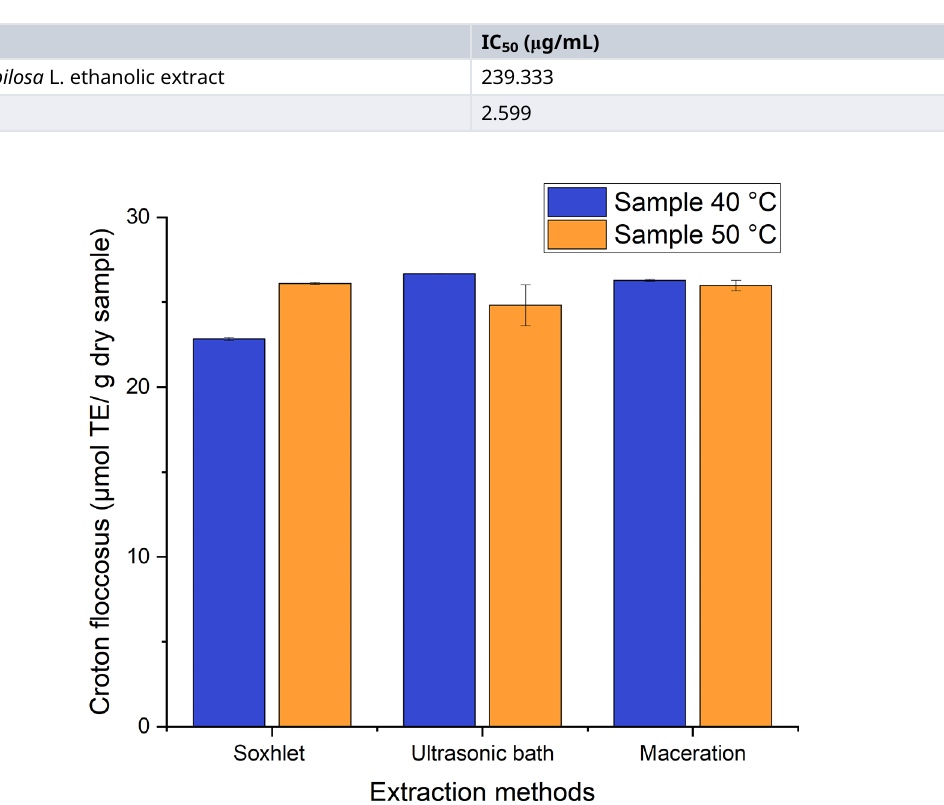
Figure 14. Antioxidant activity equivalent to Trolox of Croton floccosus.